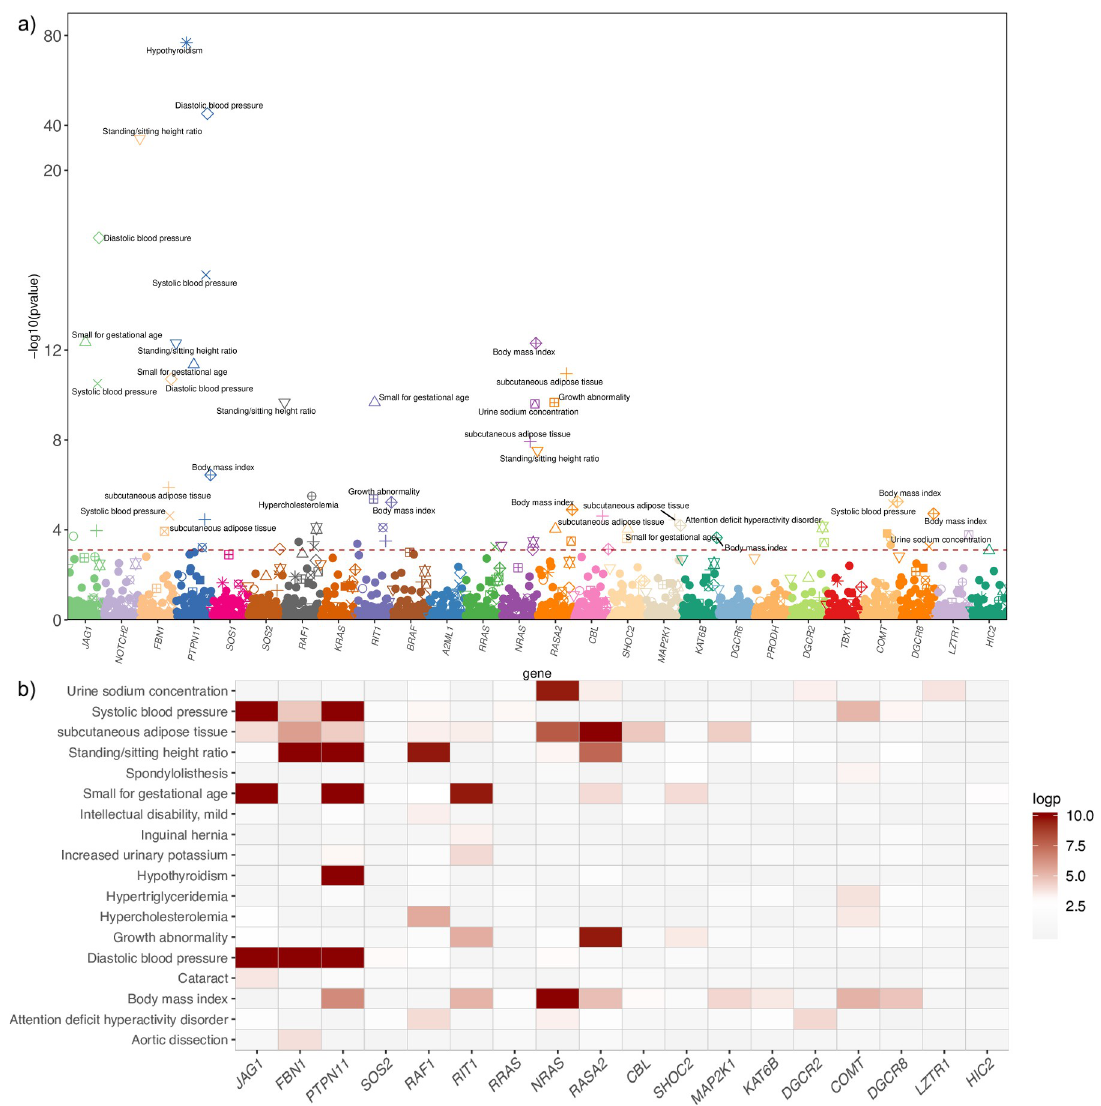
Fig 2. Primary PheWAS results at a gene level. Plot of PheWAS results for all genes and phenotypes (a). The red line represents the level of significance after FDR correction. Genes are represented by color and phenotypes are indicated by shape. Correlation plot for the set of significant gene–phenotype pairs. (b). The color represents the p-value of association and varies from none associated (grey-white) to significant association (red-dark red). For NS and RAS-opathy related phenotypes, variants in PTPN11 were associated with increased risk of hypothyroidism, high diastolic and systolic BP, and high standing/sitting height ratio (Fig 1A, Fig 1B and S3 Table). variant s in SOS2 were associated with lower systolic and diastolic BP, and lower percent of body fat (Fig 1A and S3 Table). variant s in MAP2K1 , and KAT8B were associated with lower body mass index, as well as lower level of cutaneous adipocyte tissues (Fig 1A, Fig 1B and S3 Table). variants in RASA2 were associated with body mass index, level of subcutaneous adipose tissues, a lower ratio of standing/sitting height, and growth abnormality. We also found a significant association between variants in SHOC2 and high level of Cystatin C, Creatinine, and Urea which reflect kidney dysfunction (Fig 1A, Fig 1B